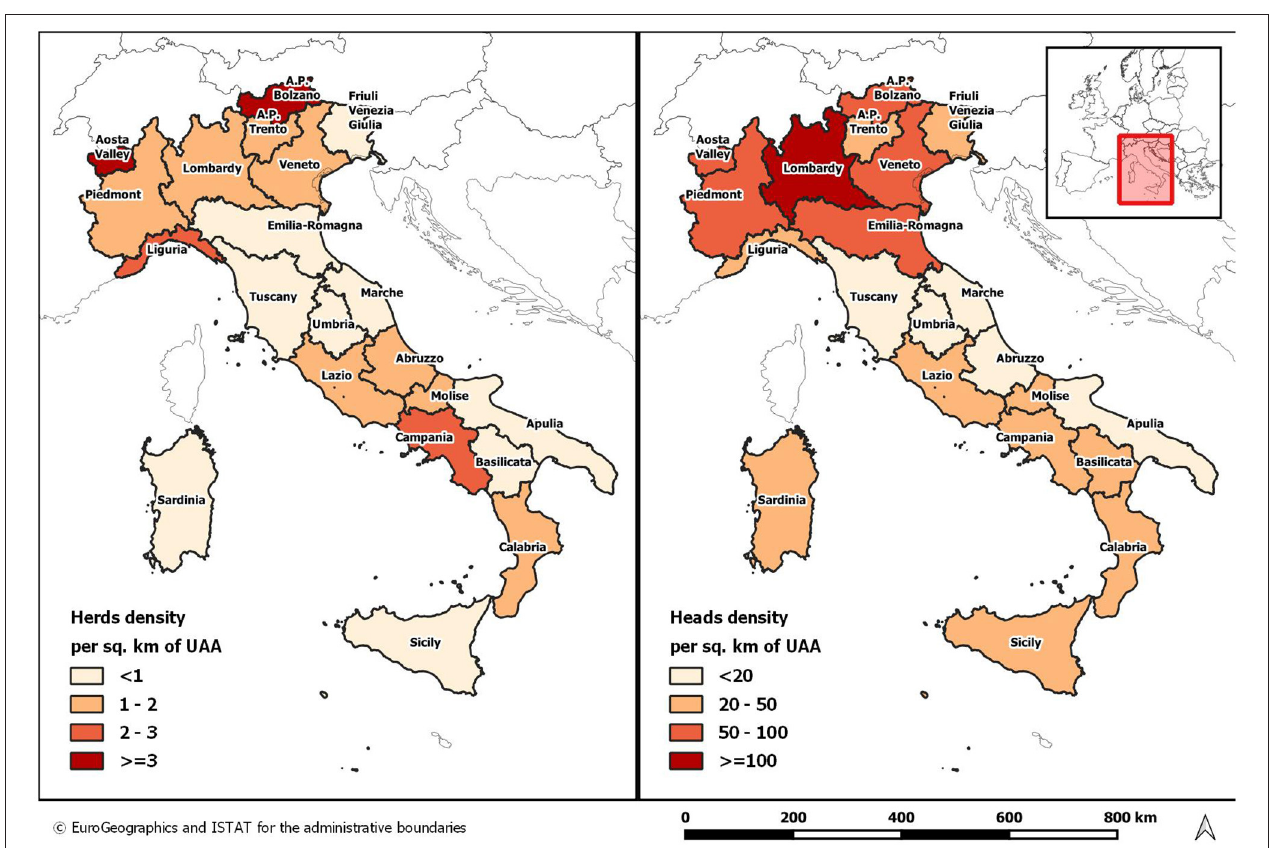
FIGURE 1 | Average density of Italian cattle population per km 2 of Utilized Agricultural Area (UAA) as of 30th June 2020.